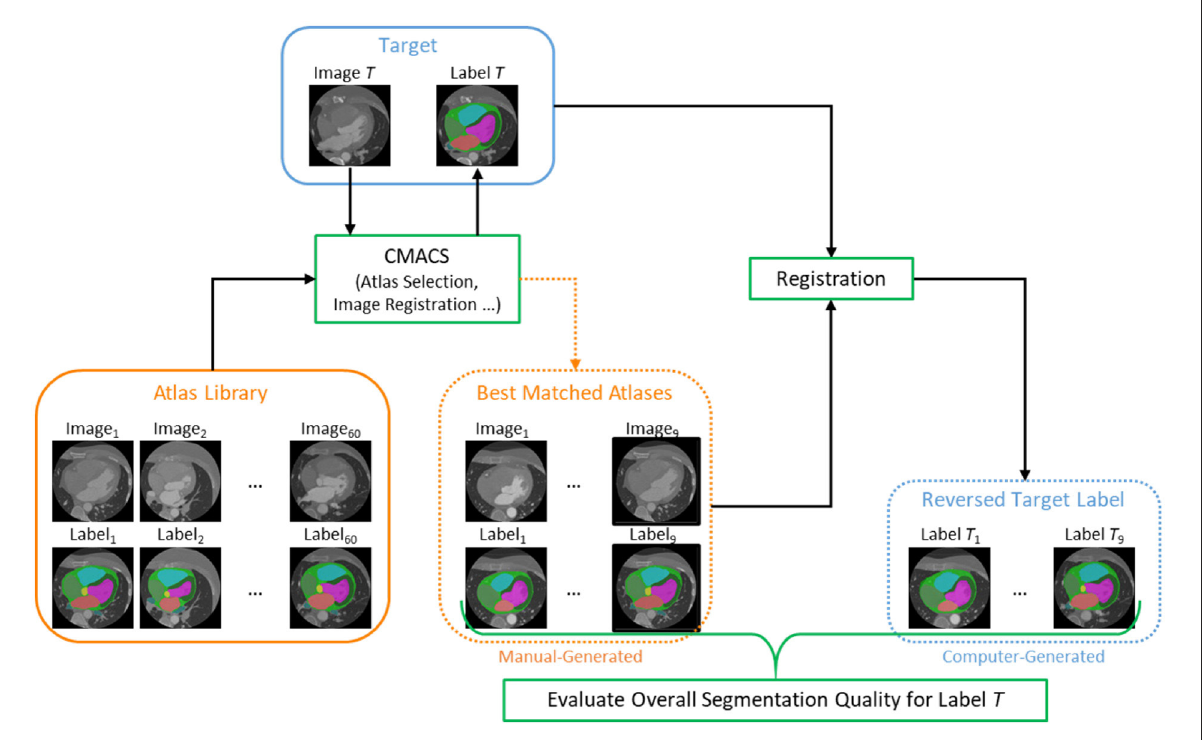
FIGURE2 Flow diagram of the proposed Optimal Label Selector (OLS) using reverse ranking to rank the segmentation accuracies for all cardiac CTA clinical studies ( n =